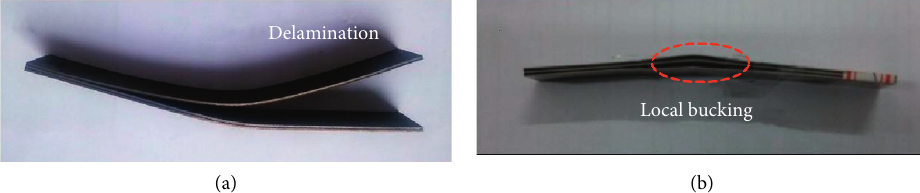
Figure 15: Ti/CF/PMR polyimide superhybrid laminate bending failure mode [56]. (a) Delamination failure; (b) local buckling